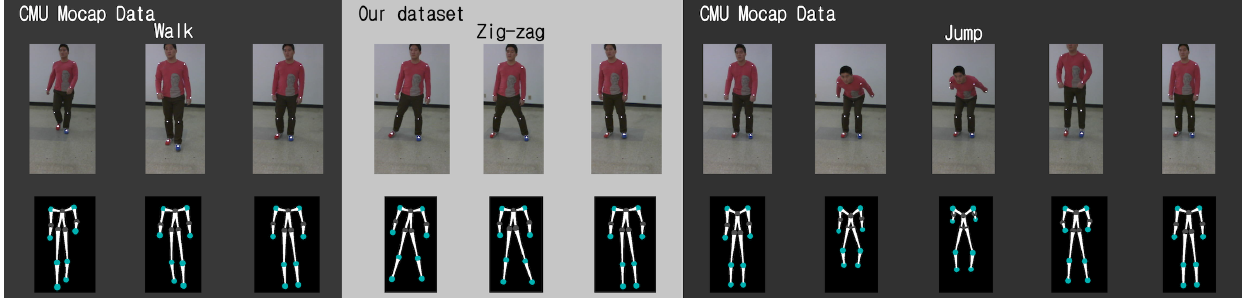
Figure 15. Reconstruction of a composite action: walk (CMU), zigzag (local) and jump